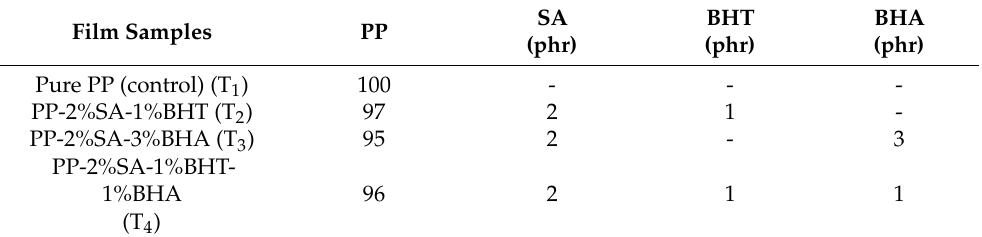
Table 1. The sample codes and formulation of active antioxidant/antimicrobial films. Film